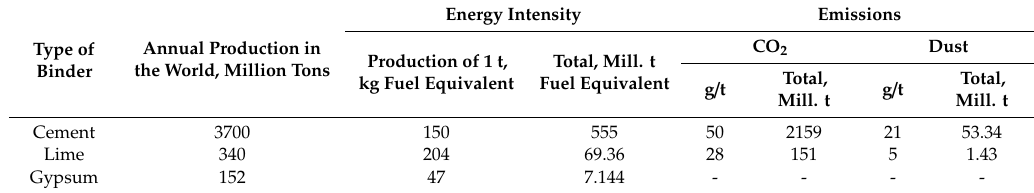
Table 1. The environmental aspect of the production of mineral binders [17–19].